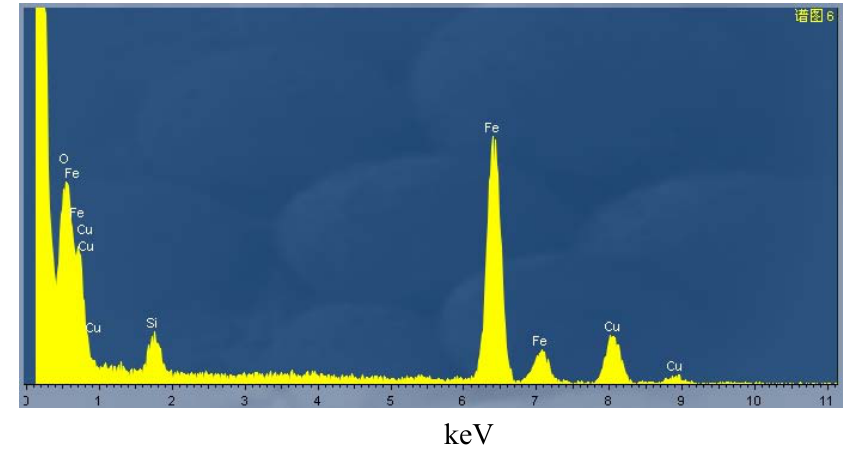
Figure 3. The X-ray fluorescent spectroscopic (XRF) spectrum of MNPs.